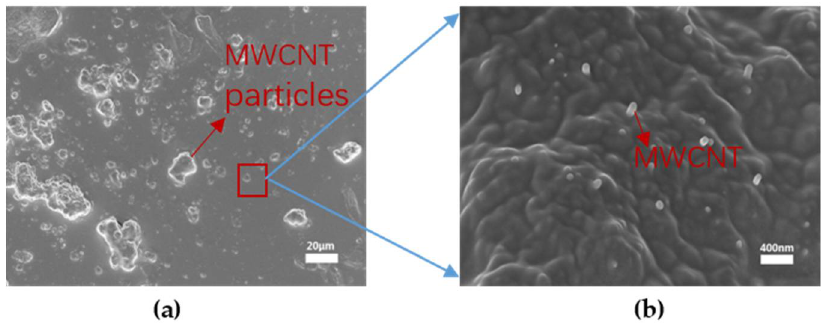
Figure 6. The SEM image showing the distribution of MWCNT in the composite. ( a ) the protrusions on the surface of PDMS layer formed by MWCNT particles combined with PDMS; ( b ) Several MWCNTs exposed out of the PDMS layer.